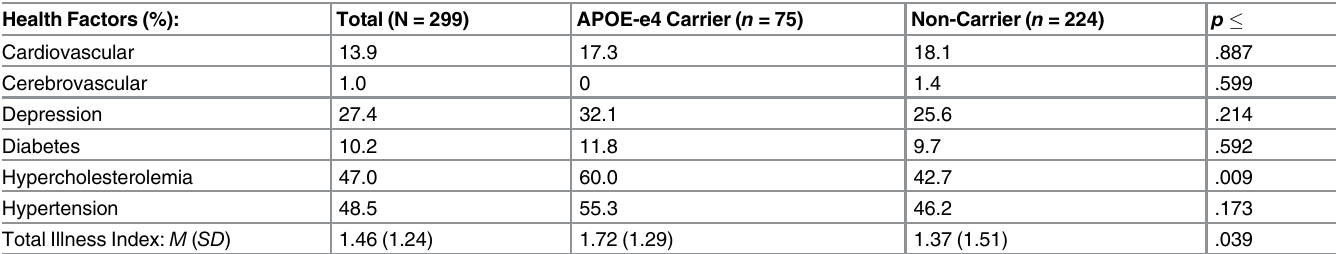
Table 2. Group differences in health risk characteristics by APOE-e4 carrier